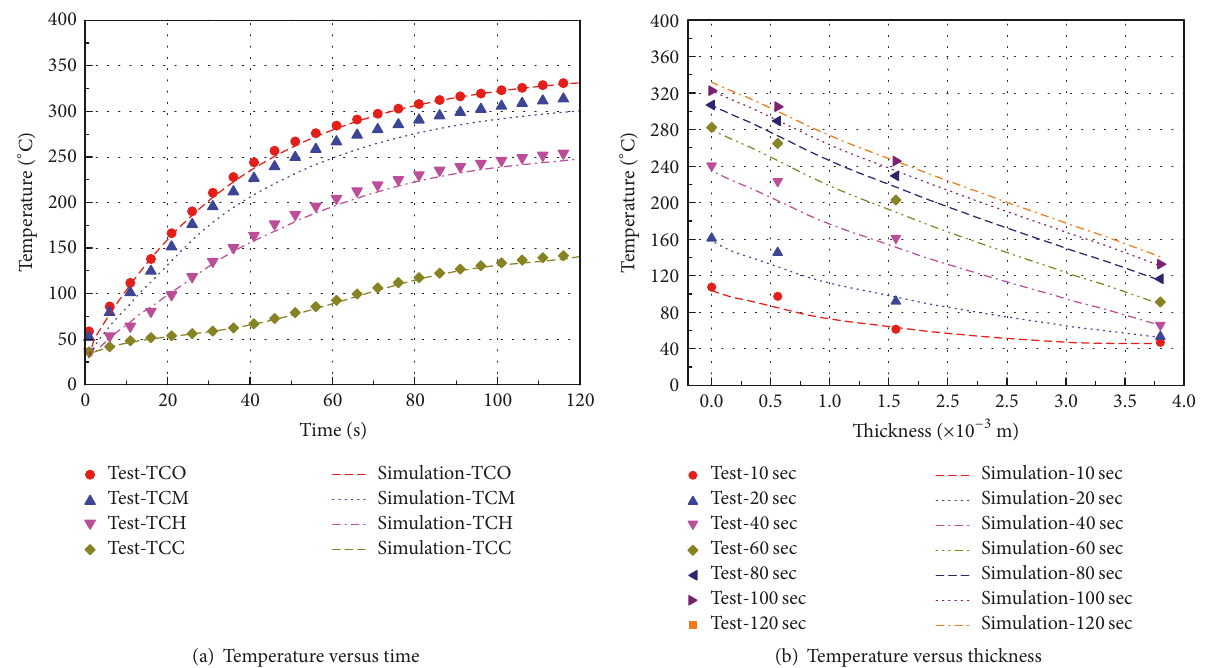
Figure 8: Simulated (continuous lines) and experimental (discrete points) temperature profiles when RH =